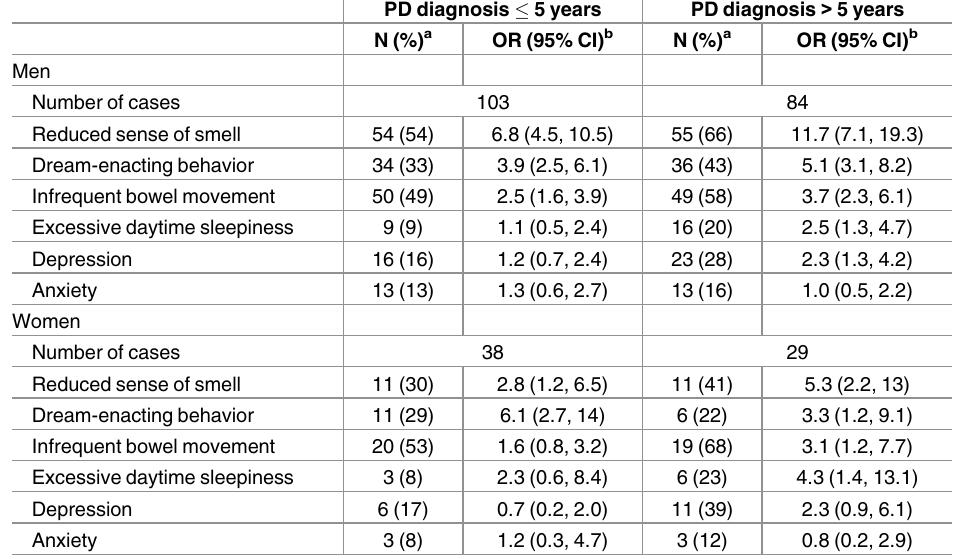
Table 3. Non-motor symptomsand Parkinson’s disease by disease duration in the Agricultural Health Study. PD diagnosis (cid:20) 5